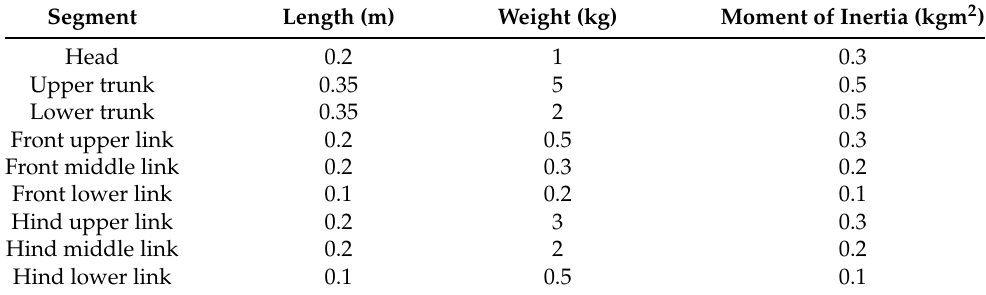
Table 3. Parameters of the